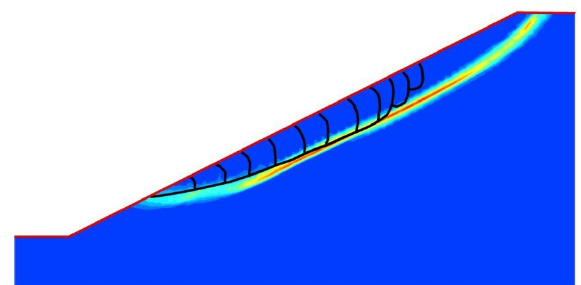
Figure 11: The factual destruction mechanism in the form of a se- ries of micro-slides observed during test F10, superimposed over a theoretical destruction mechanism obtained using the strength reduction